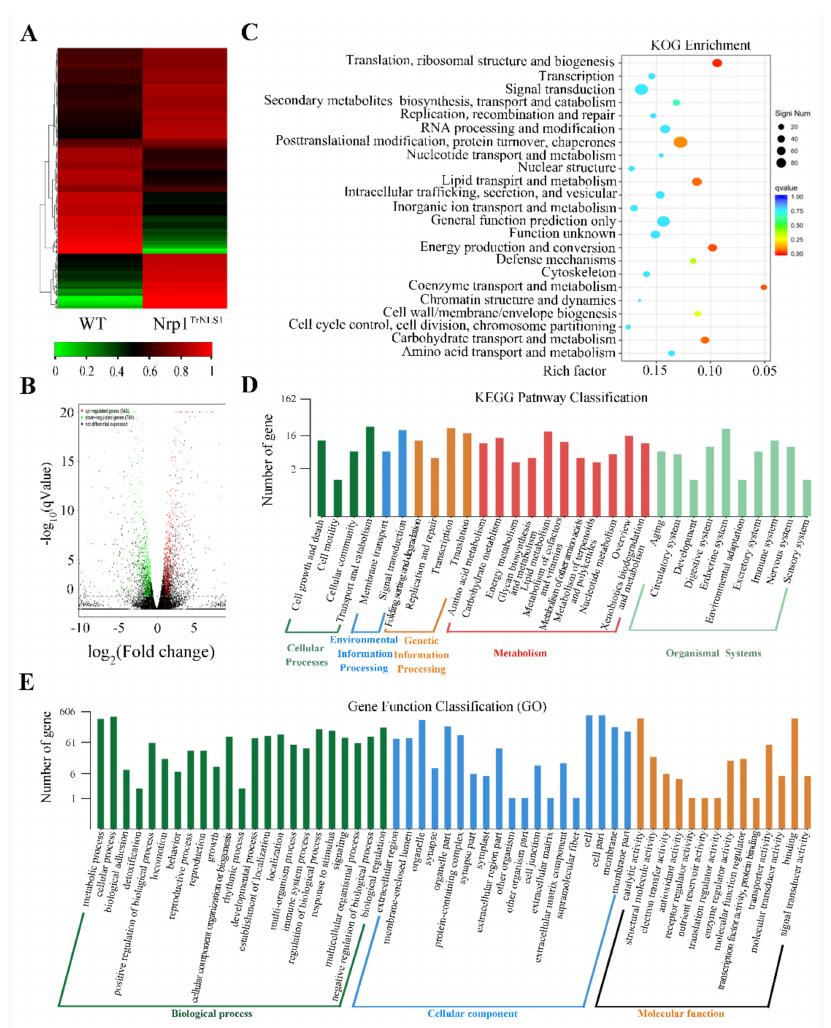
Figure 6. Identification of differentially expressed genes in Nrp1 TrNLS1 mutant. ( A ) Heatmap of DEGs in WT and Nrp1 TrNLS1 cells. DEGs with a |log2FC| > 1 are indicated in red, and DEGs with a |log2FC| < 1 are indicated in green. ( B ) Volcano plots of DEGs between samples. The